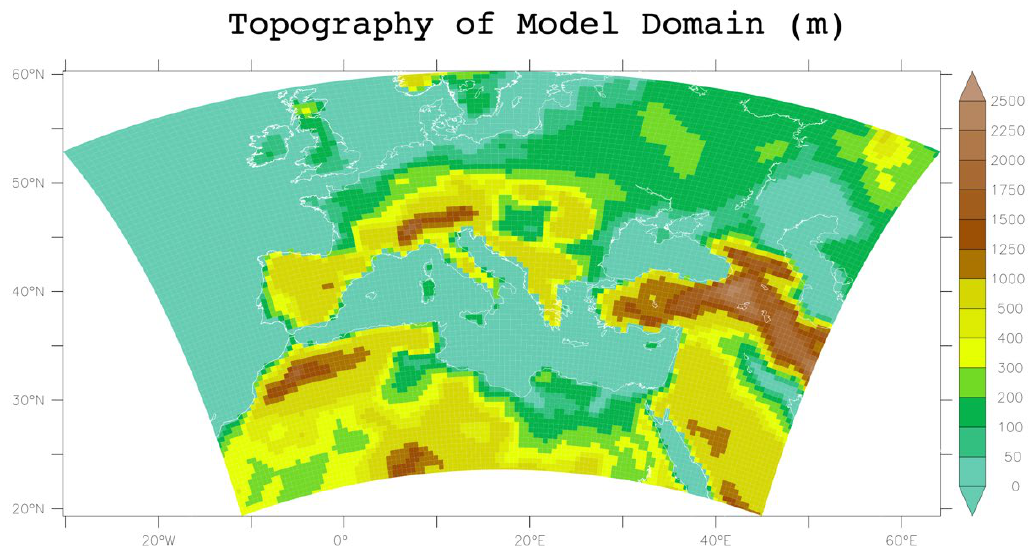
Figure 1. Topography of the domain used in numerical simulations.